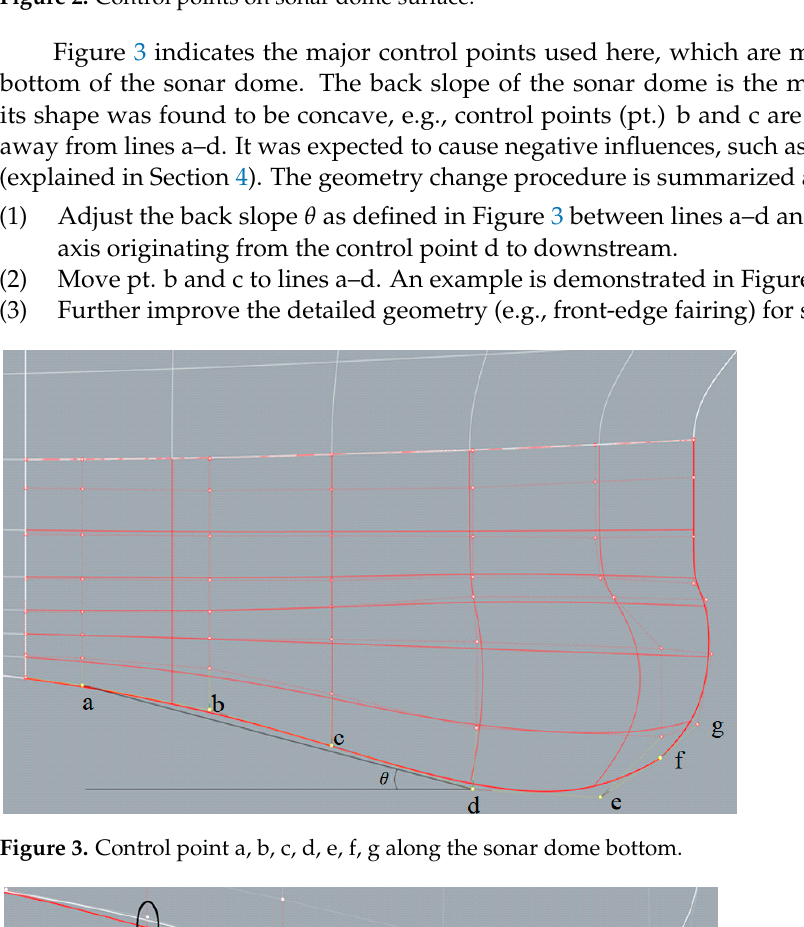
Figure 2. Control points on sonar dome surface.